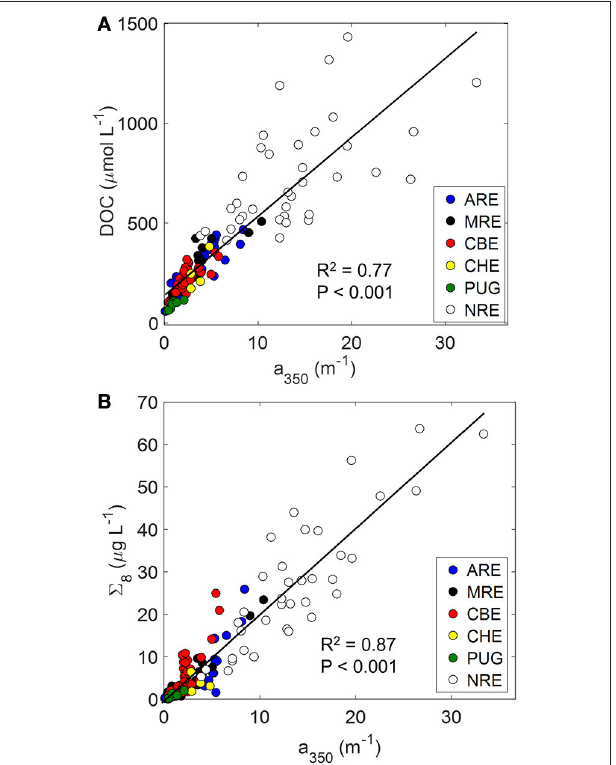
FIGURE 6 | Relationships between CDOM and (A) DOC (DOC = 40 ± 2 × a 350 + 138 ± 16) and (B) lignin ( 6 8 = 2.03 ± 0.07 × a 350 + − 0.27 ± 0.59 ), linking the optics and chemistry of DOM. Regression lines are shown along with correlation coefficients for the